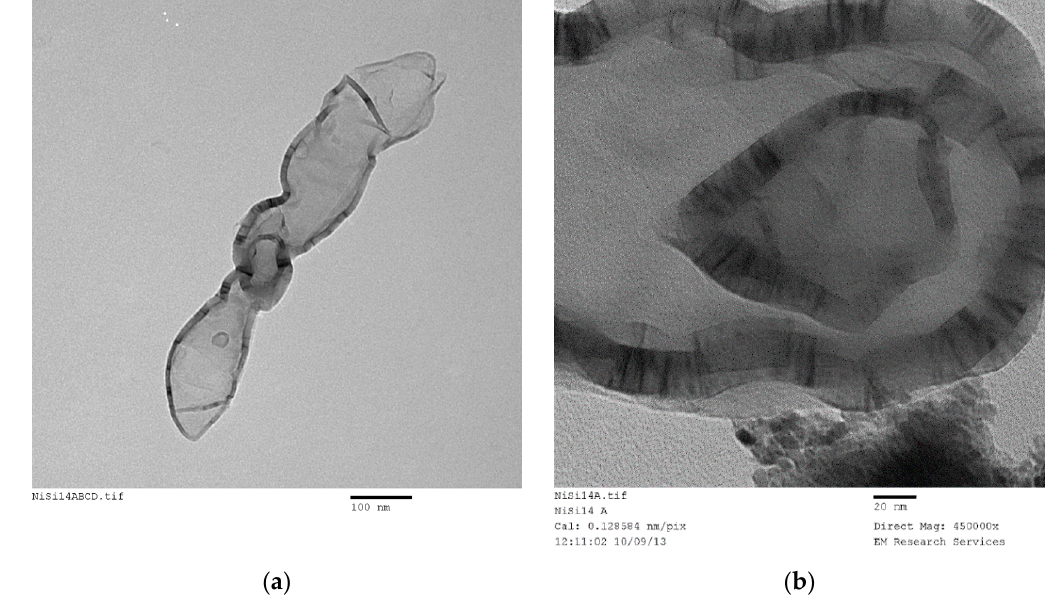
Figure 27. Presence of a complete elongated bubble in Ni/Si precursor fluid formed as a result of silica/nickel interaction during the boiling stage of the precursor fluid. ( a ) Complete bubble from Ni/Si = 1/4 Mw-ABCD (used in ammonia production). Scale bar = 100 nm; ( b ) Enlarged view of two bubbles from the catalyst oxide Ni/Si = 1/4 Mw-A. Scale bar = 20